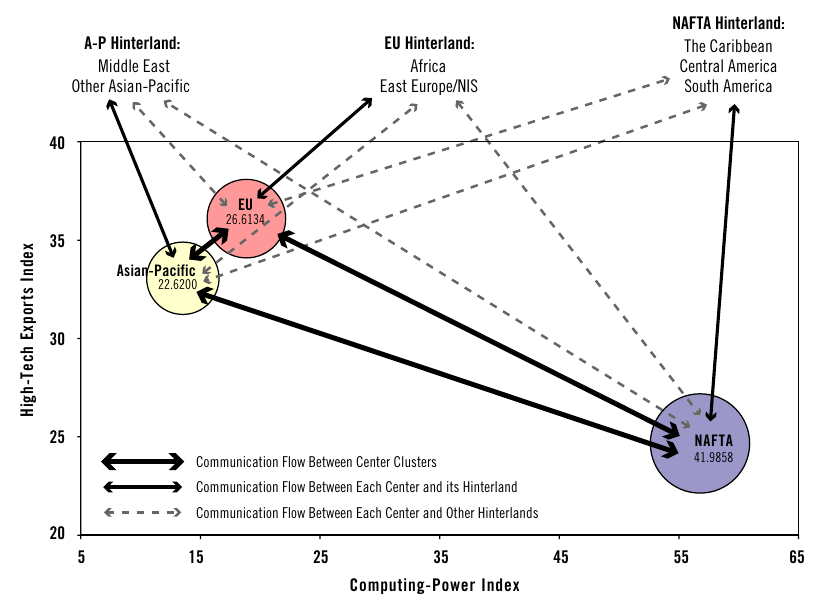
Figure 1 – Center Clusters and